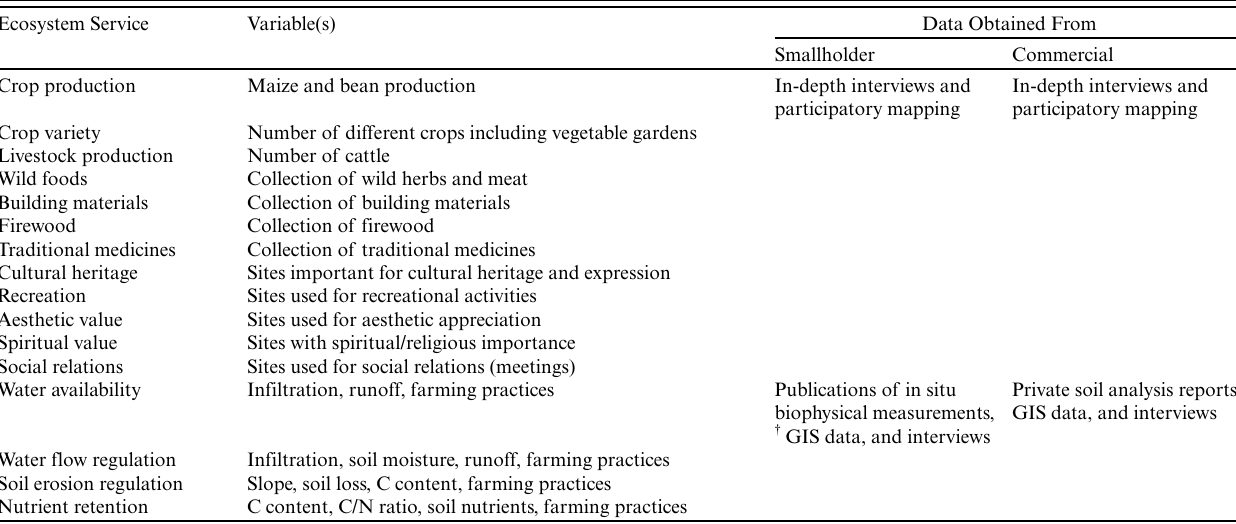
Table 1 . Overview of selected ecosystem services, variables used to quantify supply, and where data was obtained from. Ecosystem